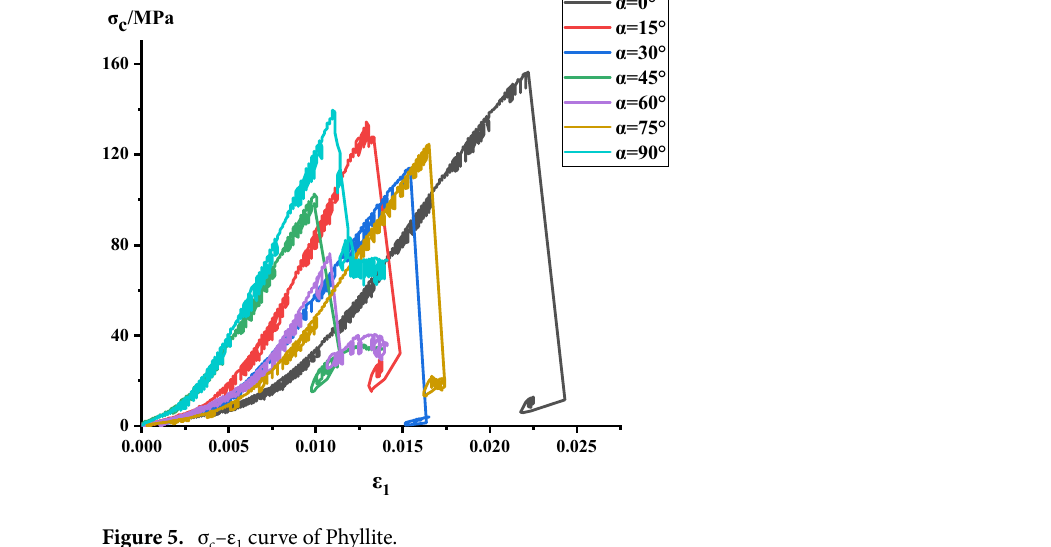
Figure 5. σ c –ε 1 curve of Phyllite.